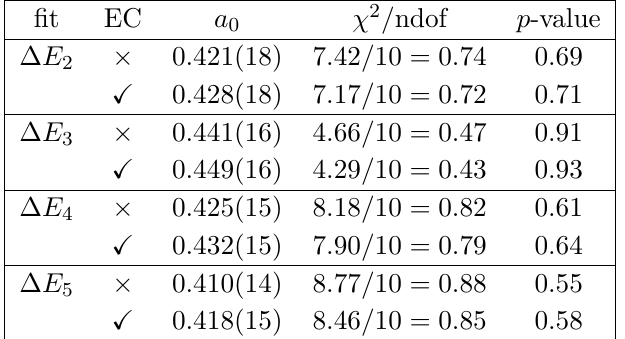
Table 4. Comparison of the results obtained from the energy shift fits to order L − 5 in the interval [14 , 24] . We provide the results with as well as without EC